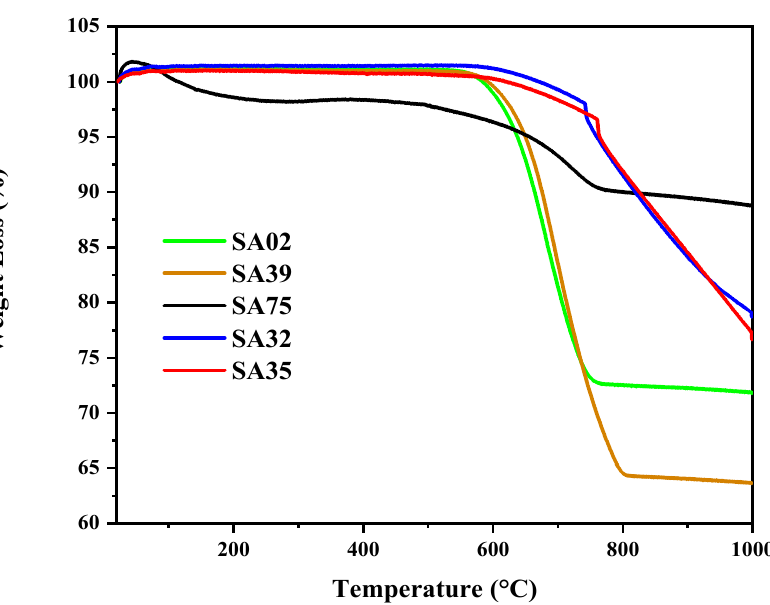
Figure 9. TGA curves for quantifying the amount of deposited carbon on the Ni-supported.